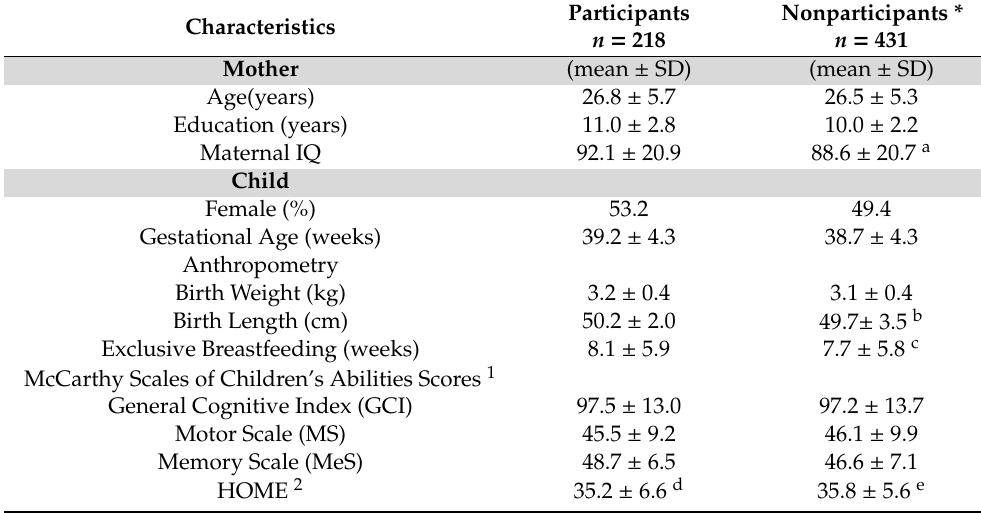
Table 1. Sociodemographic characteristics of the study mother-child pairs.